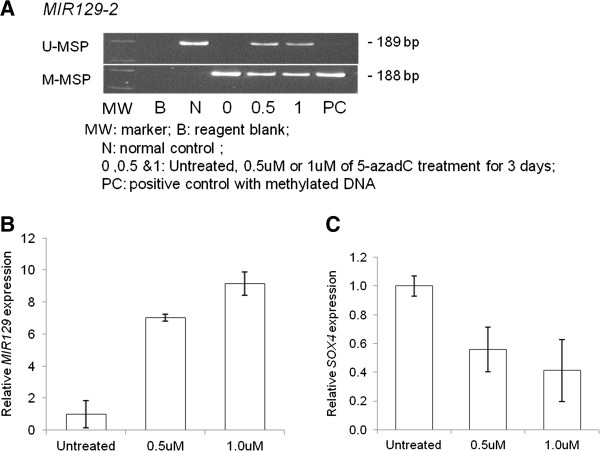
5-azadC treatment induced DNA demethylation and re-expression of MIR129 leading to re-pression of SOX4. (A) M- & U-MSP of JEKO-1 lymphoma cells upon 5-azadC treatment. (B) RT-qPCR analysis of the mature MIR129 expression upon treatment. (C) RT-qPCR analysis of the SOX4 expression upon treatment.